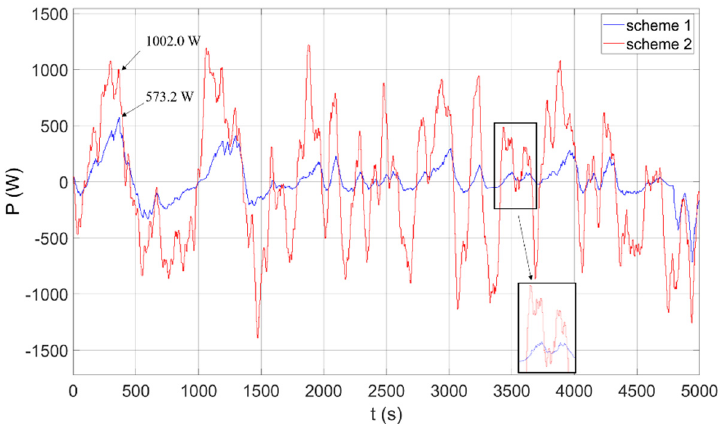
Figure 14. LiBs assumed power comparison.